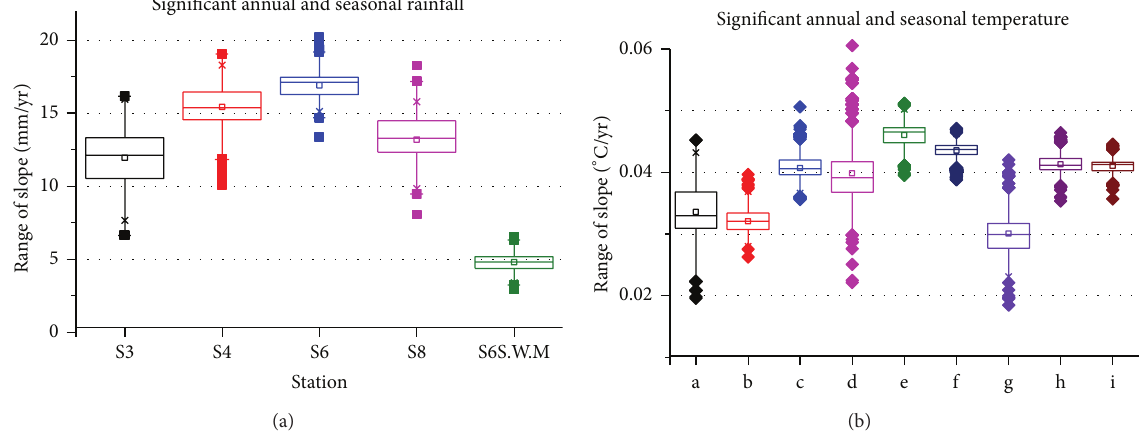
Figure 9: Boxplot of slope obtained from bootstrap method for the significant trends of annual and seasonal rainfall and temperatures (a: S9 ( 𝑇 Max ), b: S10 ( 𝑇 Min ), c: S11 ( 𝑇 Min ), d: S9 ( 𝑇 Max NE monsoon), e: S10 ( 𝑇 Min NE monsoon), f: S11 ( 𝑇 Min NE monsoon), g: S9 ( 𝑇 Max SW monsoon),